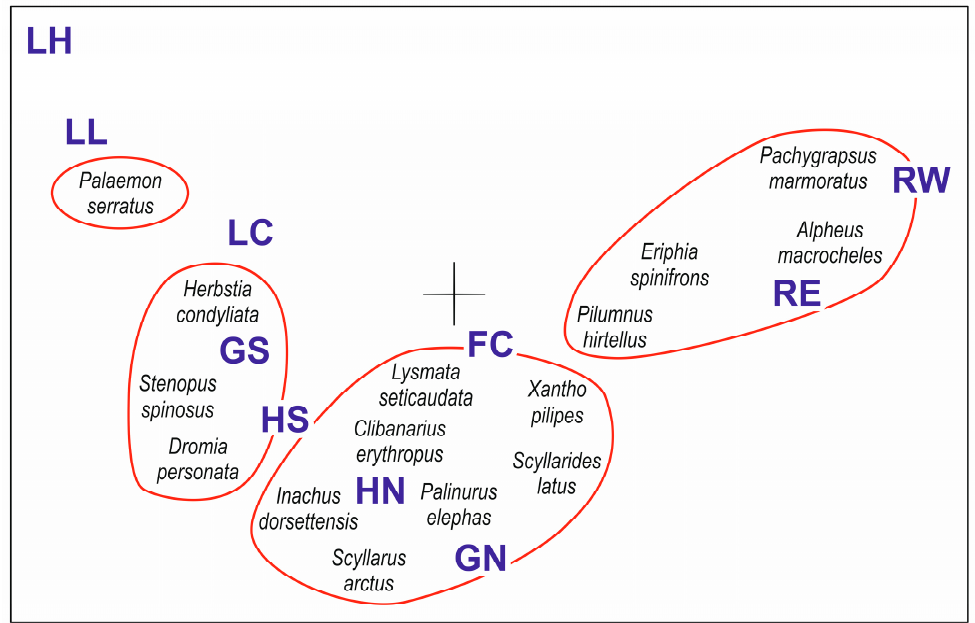
Figure 9. Number of decapod species in the different locales and stations of the Grotta Marina of Bergeggi.